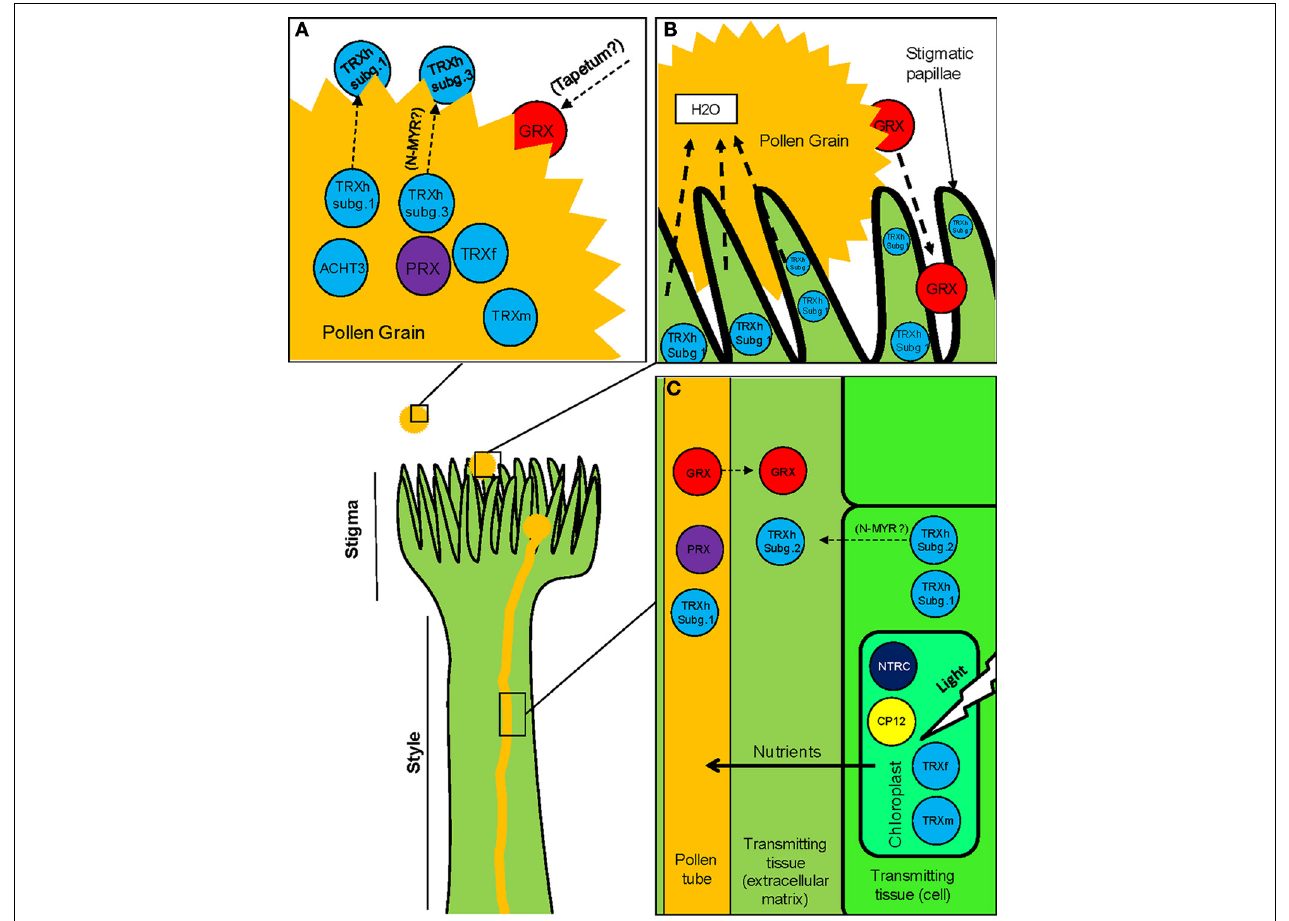
FIGURE 3 | Redoxins and related proteins are critical for pollen-pistil interactions. Illustration of the stigma and style during pollen-pistil interaction. (A) Representation of a pollen grain and the pollen coat. The presence of redoxins has been described both within the pollen grain and in the pollen coat. It is particularly remarkable the specific and conserved occurrence of h-type TRXs in the pollen grains, which can be secreted to the pollen coat. We hypothesize that N-terminal lipidations may play a role in this mechanism of secretion. Also, some redoxins synthesized in the tapetum may become integrated into the pollen coat after tapetum degeneration (B) Image representing the initial stages of the pollen-stigma interaction. Upon pollen arrival, pollen starts to hydrate, rapidly releasing